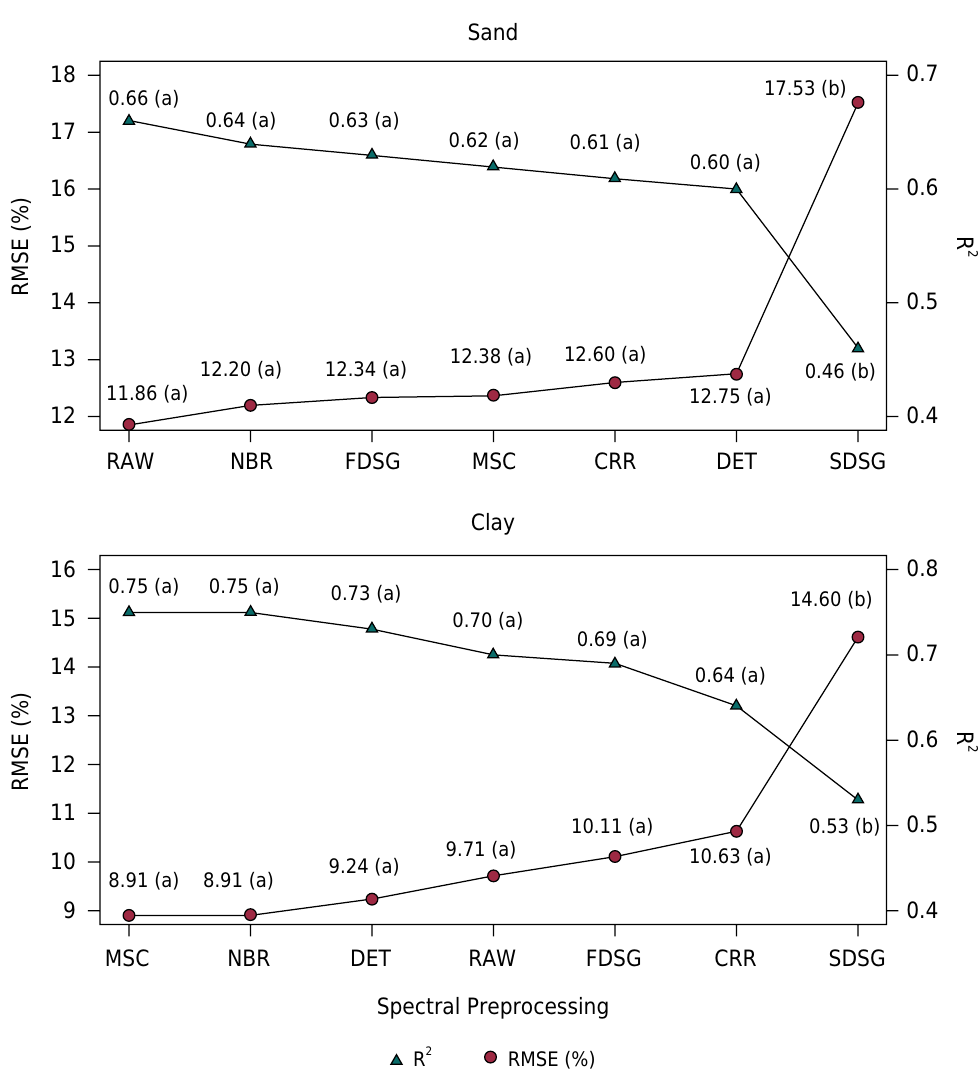
Figure 3. The mean values of RMSE and R 2 for each preprocessing technique for sand and clay content. The letters in parentheses represent the results of the Scott Knott test (significance level